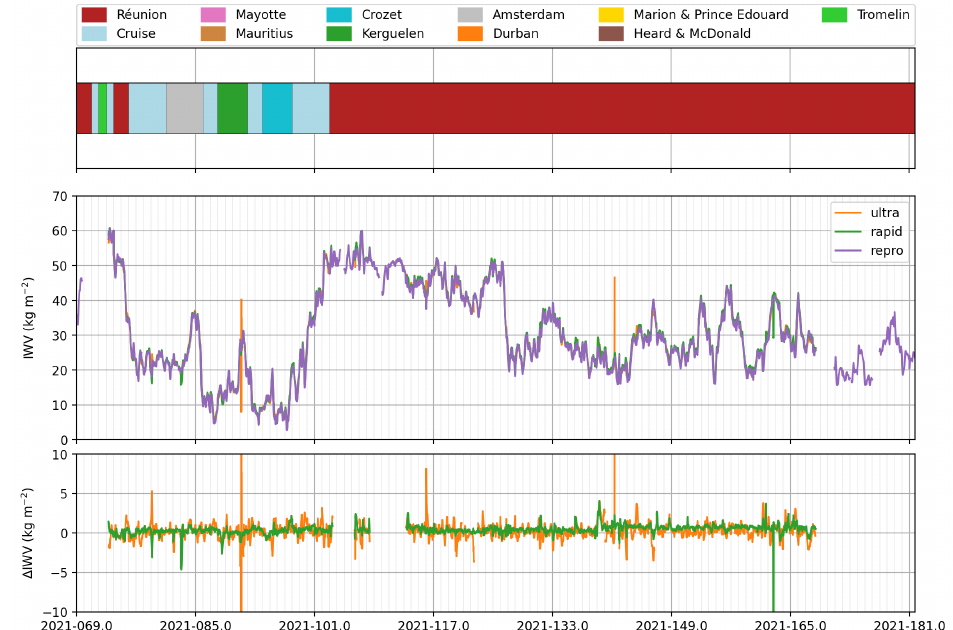
Figure 7. IWV time series along the route of the R/V Marion Dufesne. The upper panel of the figure indicates the location of the R/V Marion Dufresne. The middle panel represents the IWV time series as seen by the Marion Dufresne GNSS antenna for the repro (purple solid line), ultra (orange solid line) and rapid (green solid line) solution. The lower panel represents the difference of the ultra and rapid solutions with respect to the repro solution.